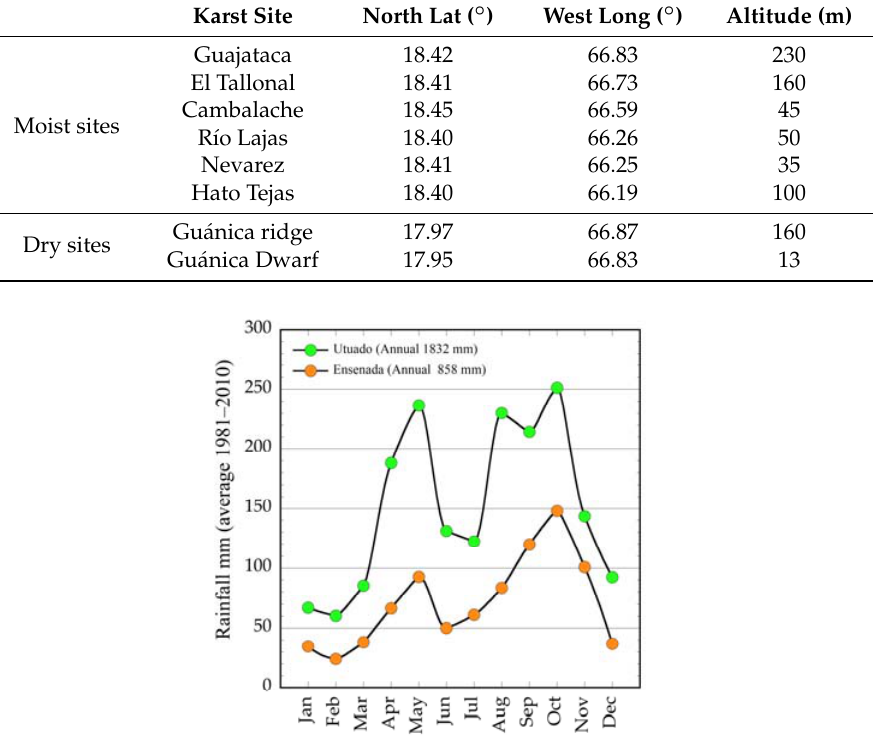
Figure 1. Average rainfall pattern of humid and dry karst sites.